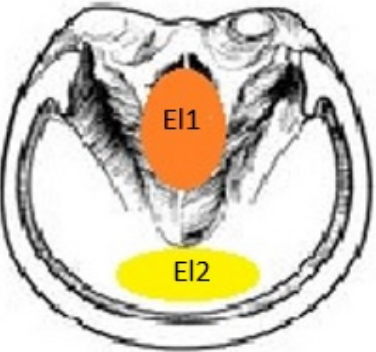
Figure 1. Sole surface: El1, frog area; El2, toe area.